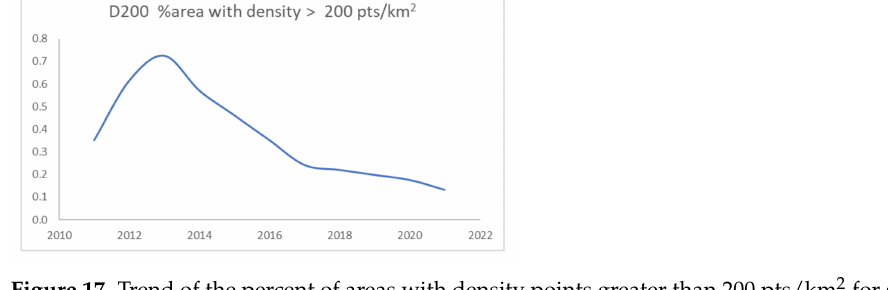
Figure 17. Trend of the percent of areas with density points greater than 200 pts/km 2 for shoplifting in the Liverpool Street